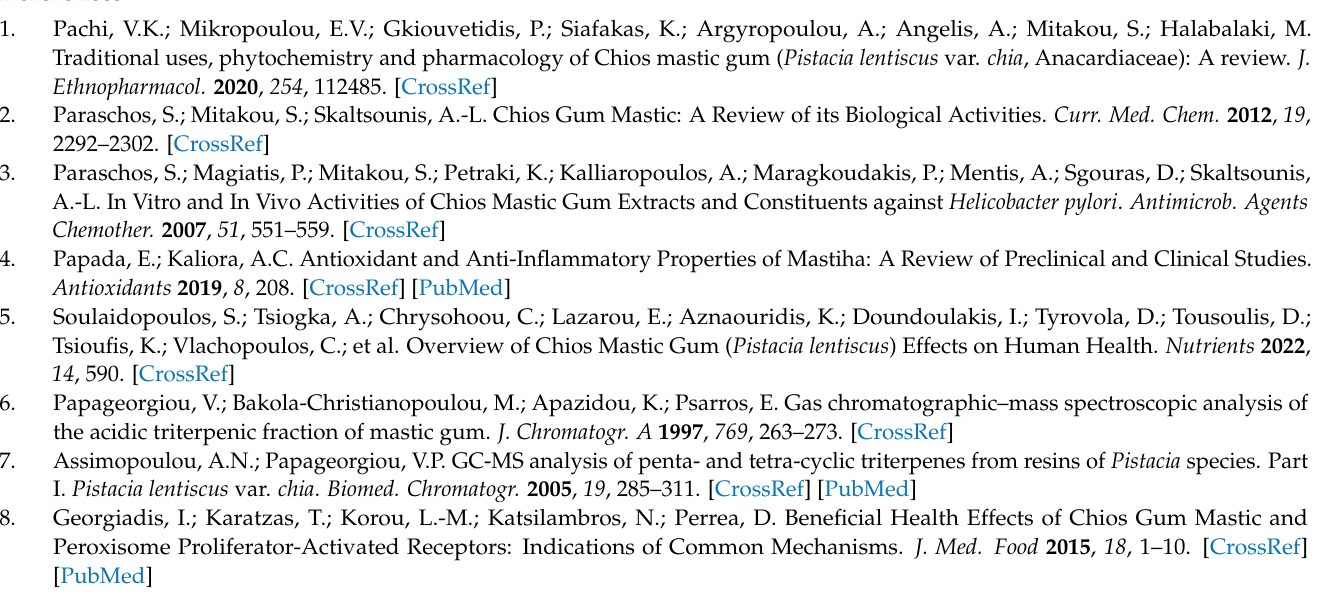
Figure S7: 1 H NMR of polar fraction in CDCl 3 400 MHz; Figure S8: Effect of Chios Mastiha fractions on PEPCK and PPAR α protein levels upon 24 h treatment; Figure S9: Effect of Chios Mastiha frac- tions on p65 protein levels upon 24 h treatment; Figure S10: Effect of Chios Mastiha fractions on procaspase-3 protein levels upon 24 h